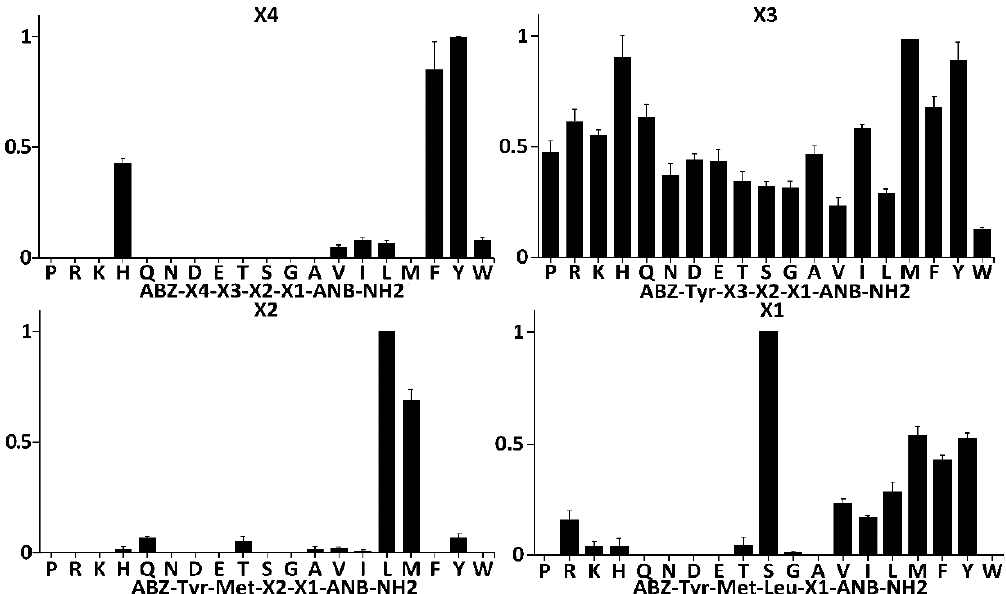
Figure 2. Substrate specificity of SplF determined using combinatorial libraries of synthetic tetrapeptide substrates (LSTS). A library of a general structure Abz ‐ X4 ‐ X3 ‐ X2 ‐ X1 ‐ Anb containing 19 sublibraries each having a defined proteinogenic amino acid at the X4 position (X ‐ axis) and an equimolar mixture of these residues at other positions was contacted with SplF and the release of fluorescence was monitored (Y ‐ axis, normalized to the most active sublibrary). X4 position was fixed with the most active residue and X3 scanning was performed in a similar manner. The procedure was repeated until all positions of the library were deconvoluted, yielding a consensus substrate Abz ‐ Tyr ‐ Met ‐ Leu ‐ Ser ‐ Anb.